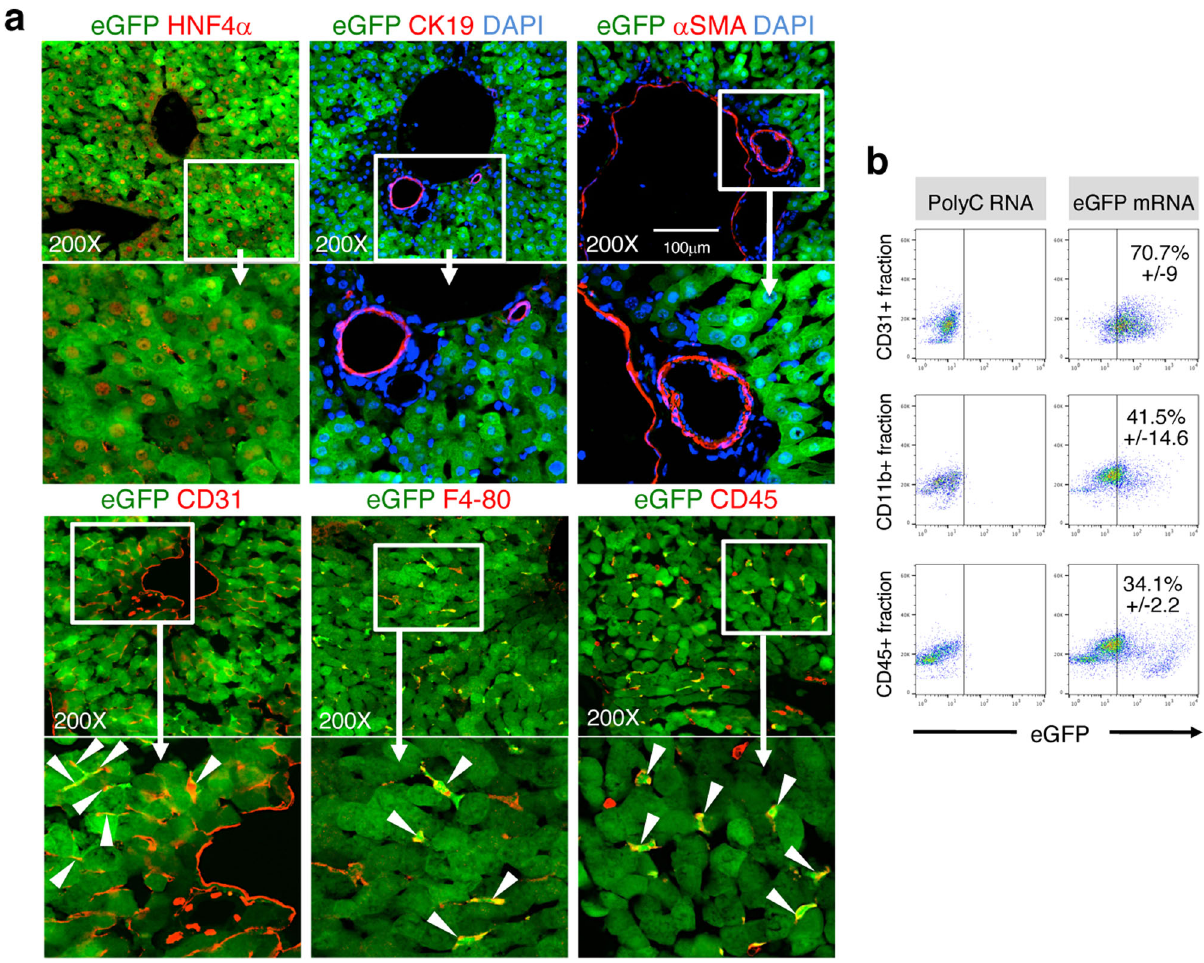
Fig. 2 Identi fi cation of transfected liver cell types 5 h after IV eGFP mRNA-LNP injection. a Co-immunostaining for eGFP (green) and liver cell type speci fi c markers (red). ×200 magni fi cation pictures and close-ups are shown. White arrowheads indicate co-stained cells. b Representative fl ow cytometry analyses showing percent of eGFP + cells in CD11b + , CD45 + , and CD31 + NPC fractions from mice injected with Poly(C) RNA-LNP or eGFP mRNA-LNP. All NPC fractions were gated for live cells present in Zombie NIR-negative populations. Data are presented as mean values± SEM for n = 3 mice per group. a Representative images from 3 mice injected with eGFP-mRNA-LNP and 2 mice injected with Poly(C) RNA-LNP. Source data are provided as a Source Data fi le. The scale bar represents 100 μ m for all ×200 magni fi cation